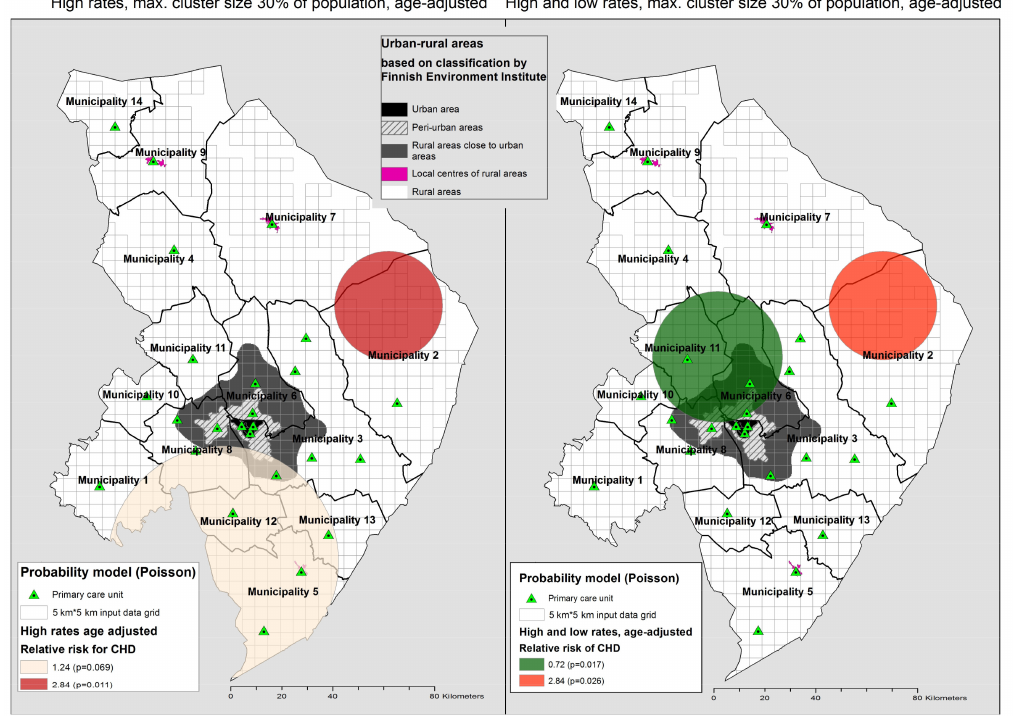
Figure 4. Disease clusters and low risk clusters of acute coronary heart disease and/or invasive treatment in 2011–2014 analysed at cluster size of maximum 30% of population at risk in North Karelia Hospital